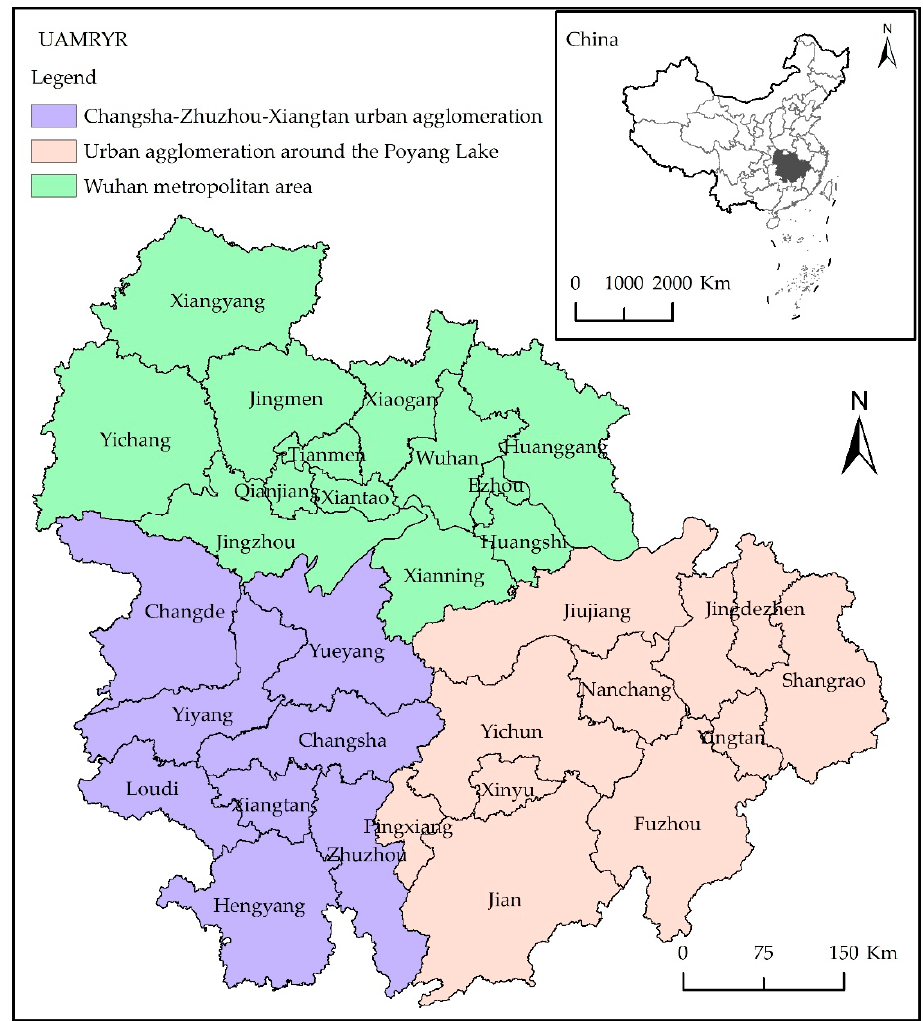
Figure 1. The location of the study area.